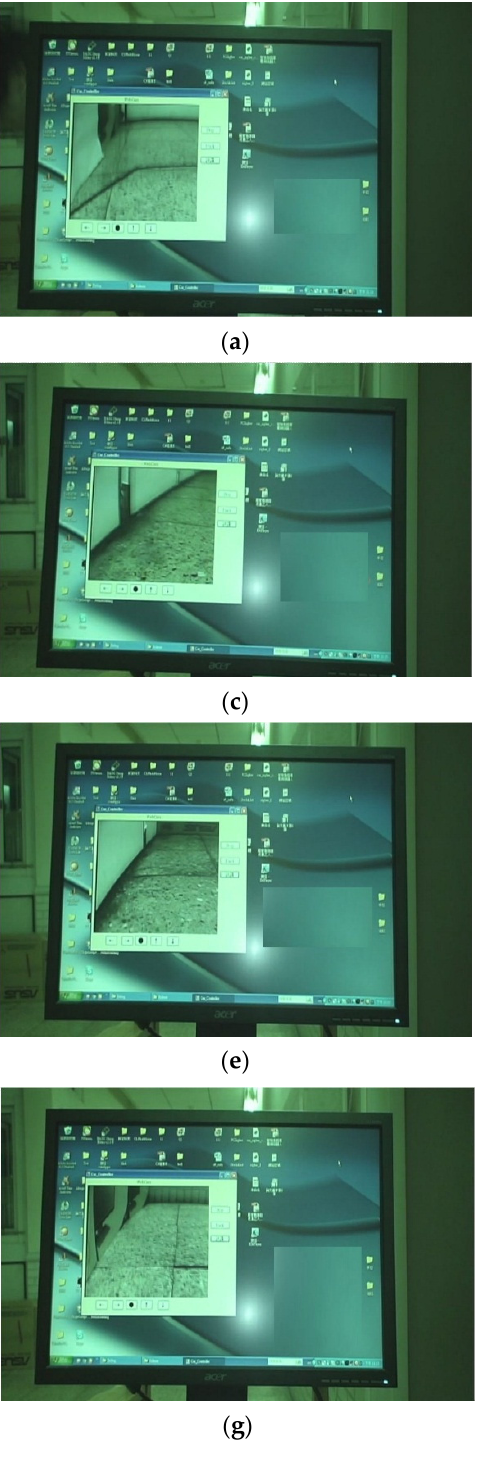
Figure 27. Captured images on PC screen. ( a ) Captured image on PC screen at Figure 26a position; ( b ) Captured image on PC screen at Figure 26b position; ( c ) Captured image on PC screen at Figure 26c position; ( d ) Captured image on PC screen at Figure 26d position; ( e ) Captured image on PC screen at Figure 26e position; ( f ) Captured image on PC screen at Figure 26f position; ( g ) Captured image on PC screen at Figure 26g position; ( h ) Captured image on PC screen at Figure 26h position.